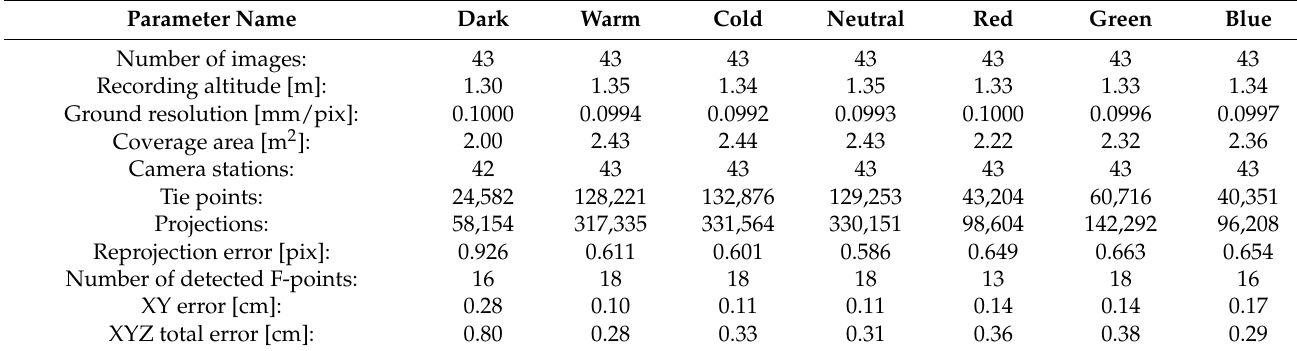
Table 4. Summary of conducted studies.